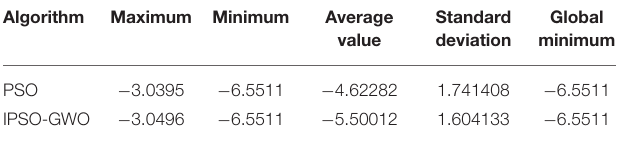
TABLE 8 | Levy function test